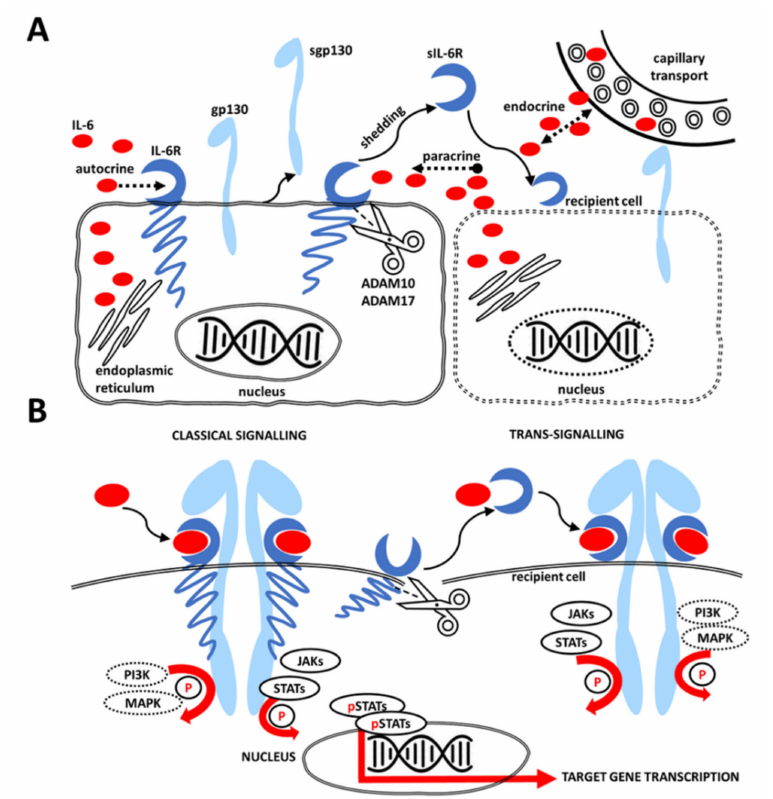
Figure 1. ( A ): All cells express signal transducer glycoprotein gp130. This molecule can be membrane- bound (gp130) or soluble (sgp130). Expression of IL-6 and its receptor, IL-6R, can be cell-type restricted. IL-6R, if expressed, can be bound to the membrane or it can be released as a soluble receptor (sIL-6R) due to the protease activity (by ADAM10 or ADAM 17). Once released from the membrane (shedding), it can also reach cells that do not express their own IL-6R. The IL-6 cytokine can act on the cell of the same origin (autocrine effect), on the neighboring cells (paracrine effect) or even exert systemic effects of endocrine nature (it is transported via the blood stream into capillaries). ( B ): Activation of gp130 by the IL-6/IL-6R complex (classic signaling) or by IL-6/sIL-6R (trans-signaling) leads to tyrosine phosphorylation (“P”) of transcription factors JAKs/STATs, PI3K and MAPK. Upon their phosphorylation, the regulatory molecules transmit the signal downstream, translocate into the nucleus and bind to enhancers of IL-6-type cytokine target